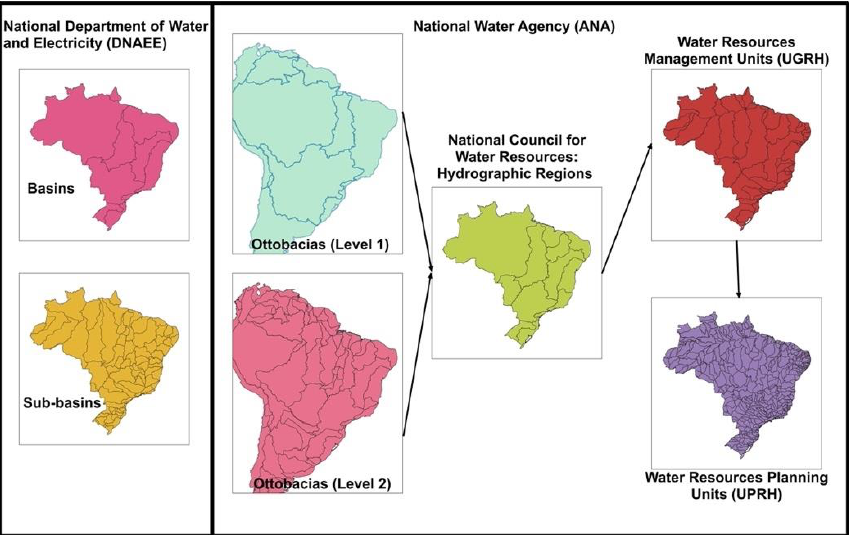
Figure 5 . The basins and sub-basins in Brazil elaborated by DNAEE are portrayed on the right. On the left are the Ottobacias ’ derivation of water resources management